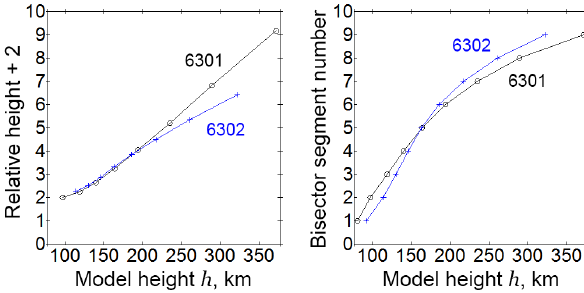
Figure 6. Left: Close to linear relation between “relative” and model heights. Right: Close to quadratic dependence between the model height and the intensity of the profile wings, linked to bisector segment. The data taken from Table 1